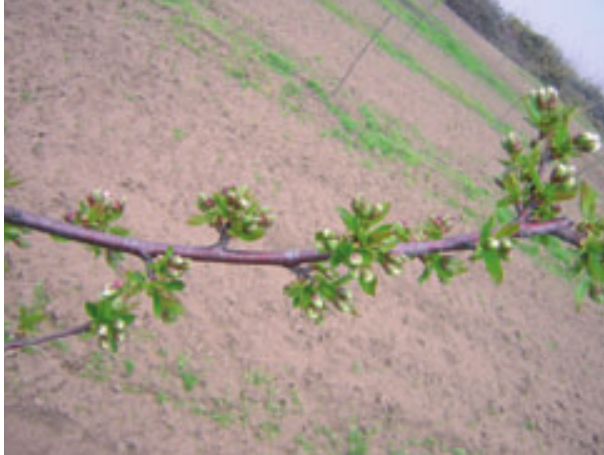
Figure 4. A branch of variety ’Achat’ produceing many bouquets of flower buds (Debrecen-Pallag, 2010)